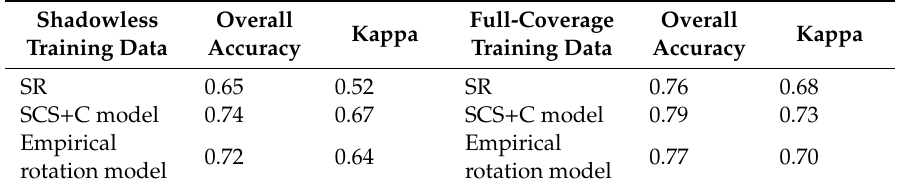
Table 4. Classification accuracy with di ff erent training data. SR represents the data before correction, and SCS + C model and empirical rotation model represent the data after correction.